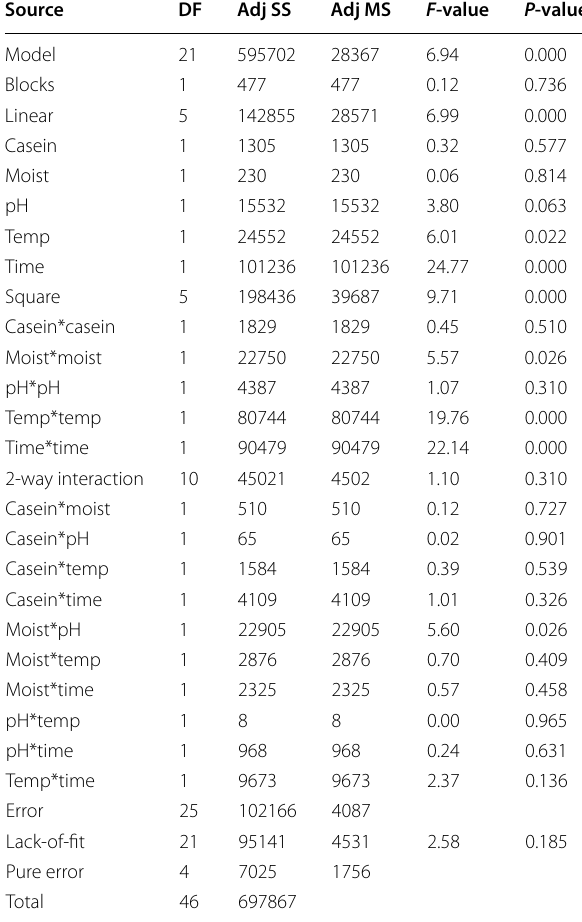
Table 6 ANOVA for the spMCA